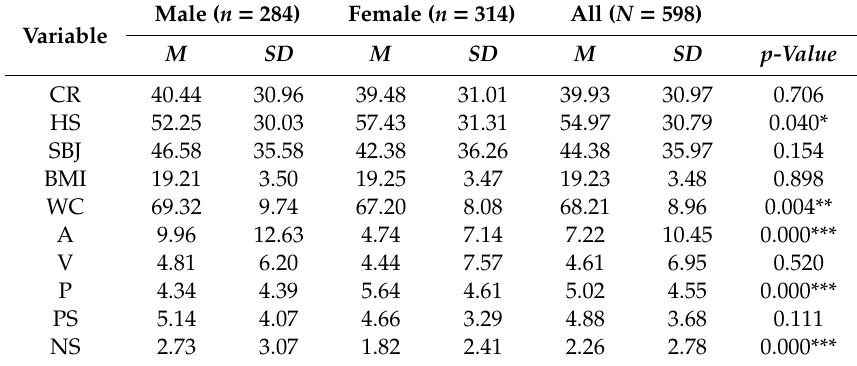
Table 1. Average percentiles in physical fitness (PF) and average nominations in social behaviors. Di ff erences by sex.